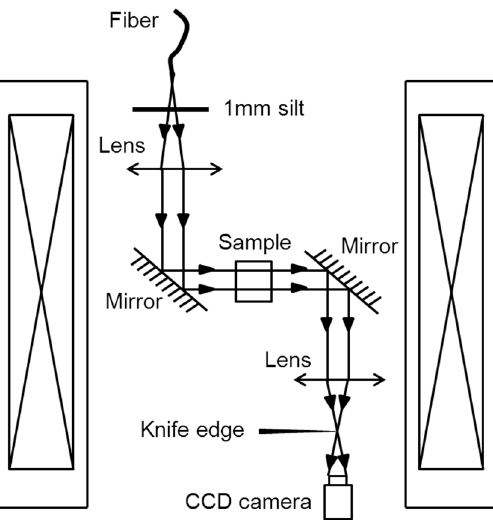
Figure 7. Schematic drawing of the Schlieren microscope in a magnetic field [52].